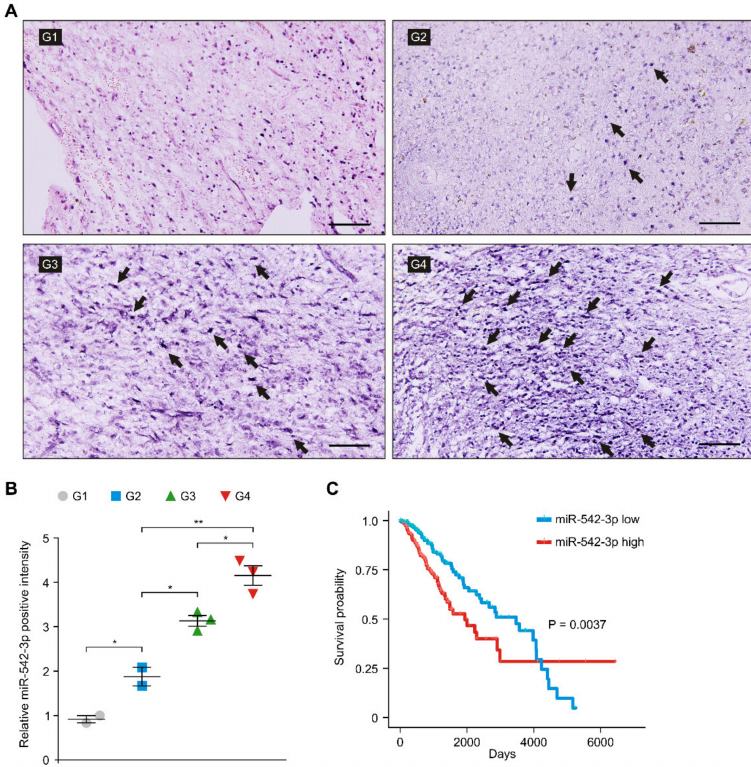
Figure 3. The levels of miR-542-3p were elevated in patients with high-grade gliomas. ( A ) Representative ISH images of miR-542-3p expression in tissues from patients with low- and high-grade gliomas (G1; grade I, G2; grade II, G3; grade III, G4; grade IV) showing miR-542-3p positive (purple) in glioma cells ( n = 10 images per individual subject, n = 3 per group). Scale bars, 100 µ m. Black arrows indicate miR-542-3p positive cells. ( B ) Quantification of miR-542-3p positive glioma cells from ISH images in tissues from low- and high-grade patients with gliomas (G1, G2, G3, G4) ( n = 10 images per individual subject, n = 3 per group). Data are mean ± SD. **, p < 0.01; *, p < 0.05 by Student’s two-tailed t -test. ( C ) Survival curve of patients by median survival rate with log-rank test with low levels (blue) and high levels (red) of miR-542-3p ( n = 690) was determined from the GBM and LGG datasets from the TCGA. p = 0.0037 by two-sided and one-sided Kaplan–Meier estimation